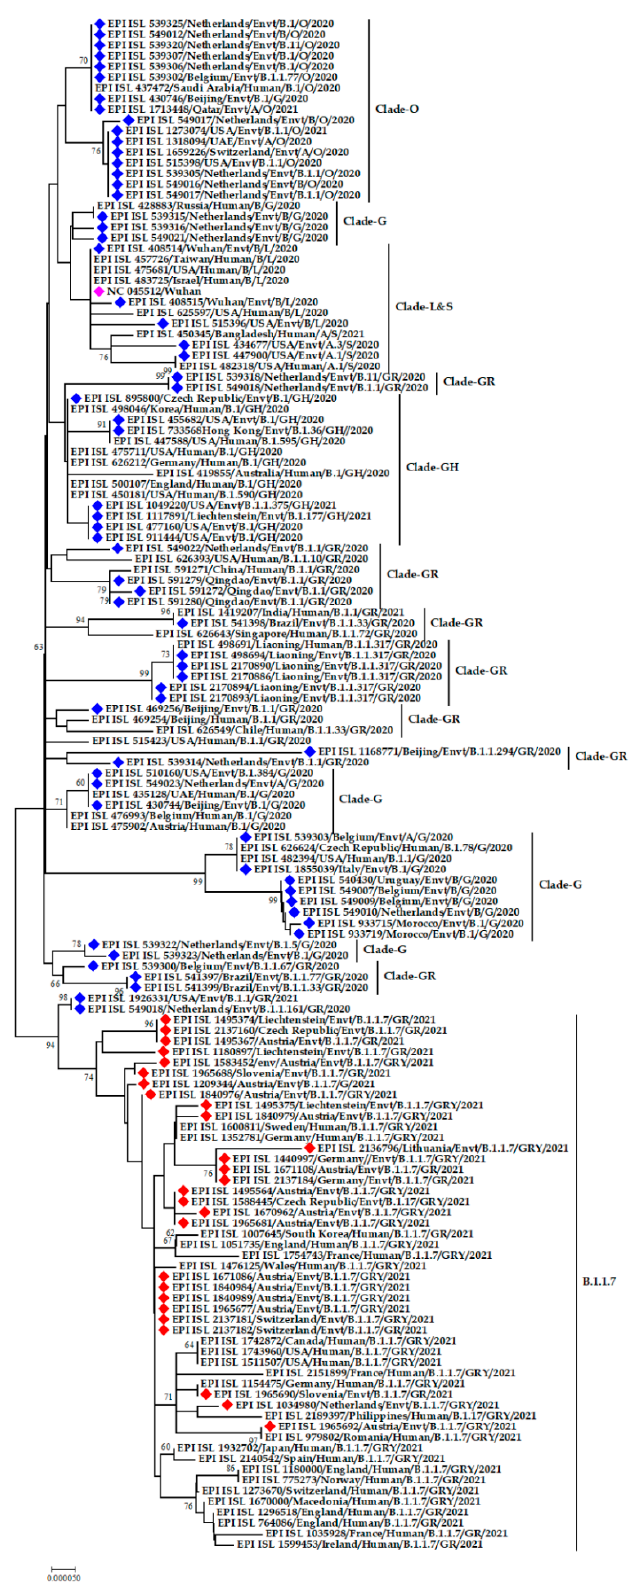
Figure 3. Phylogenetic analysis of SARS-CoV-2 genome sequences detected in environmental samples. Blue and red color denotes environmental strains, red color denotes the environmental alpha variants, fuchsia pink color refers to the reference sequence from Wuhan, China.